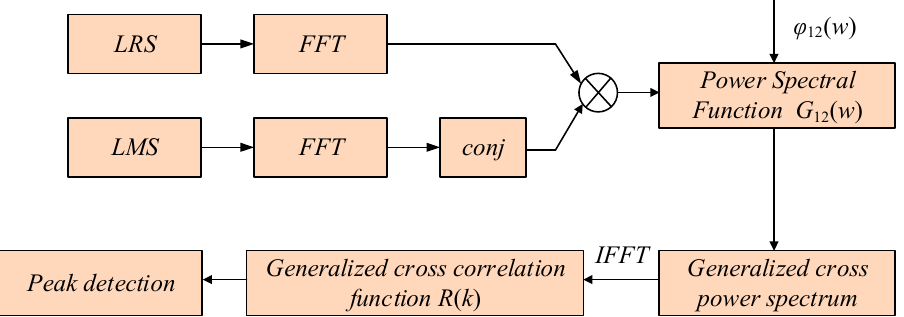
Figure 4. Flowchart of generalized cross-correlation algorithm. The local reference signal and the local measurement signal are Fourier transformed. The conjugate of the transformed local measurement signal is taken, and the two signals are convoluted to obtain the cross-correlation power spectrum. The generalized cross-correlation function is obtained using the inverse Fourier transform of the generalized cross-correlation power spectrum weighted by the cross-correlation power spectrum. The peak position of R ( k ) is